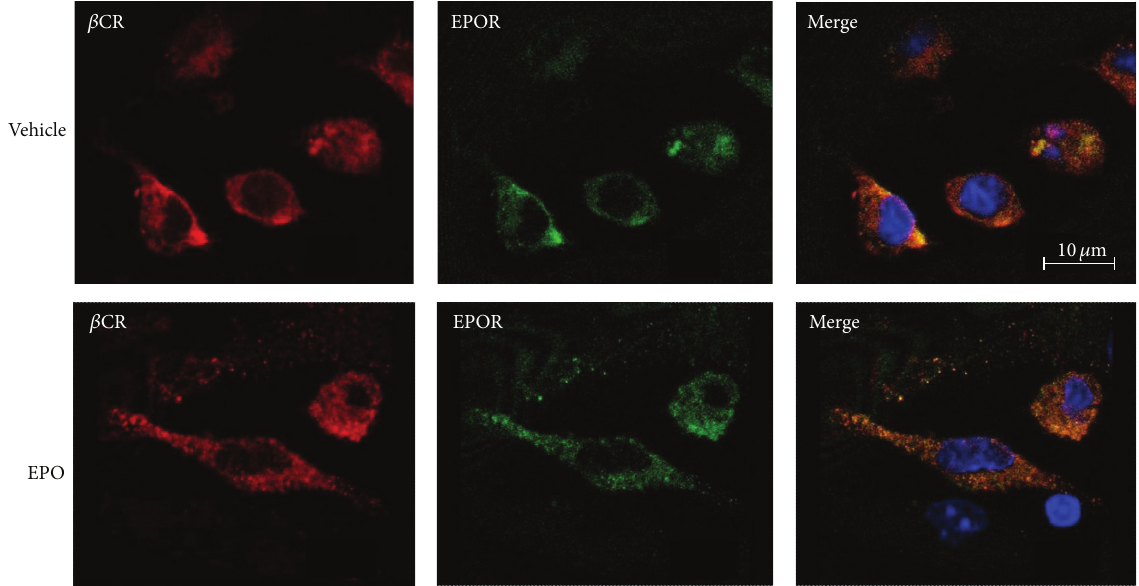
Figure 2: 𝛽 CR colocalizes with erythropoietin receptor (EPOR) in macrophagesbone-marrow-derived macrophages were treated with vehicle (PBS) or EPO (5U/mL) for 10min. Cells were fixed and immunostained with anti- 𝛽 CR or anti-EPOR Ab for confocal microscopy examination. Nuclei were stained with